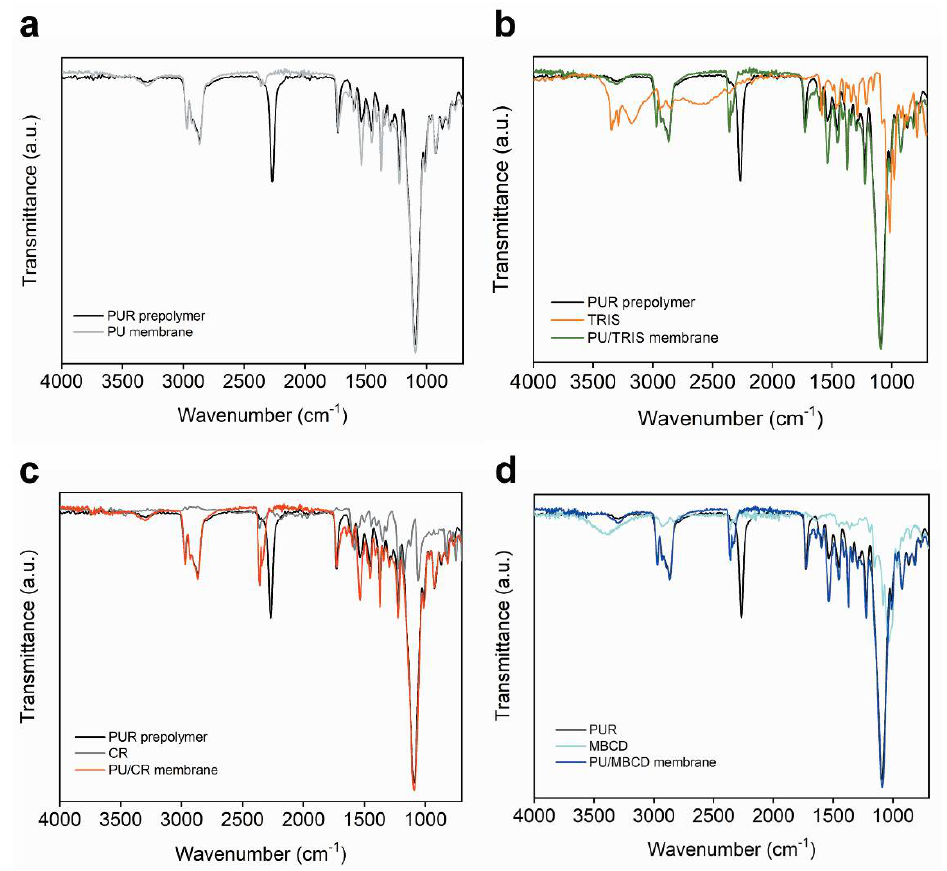
Figure 4. Spectra of each of the PU-based membranes and the pure single components used to prepare them: ( a ) spectra of the PU membrane (grey) and the PUR prepolymer (black); ( b ) spectra of the PU/TRIS membrane (green), PUR prepolymer (black) and TRIS (orange); ( c ) spectra of the PU/CR membrane (red), PUR prepolymer (black) and CR (grey); and ( d ) spectra of the PU/MBCD membrane (dark blue), PUR prepolymer (black) and MBCD (light blue). The spectra of the PU (grey line, Figure 4a), PU/TRIS (green line, Figure 4b), PU/CR (red line, Figure 4c) and PU/MBCD (dark blue line, Figure 4d) membranes are mainly characterized by a very weak broad band at approximately 3300 cm − 1 corresponding